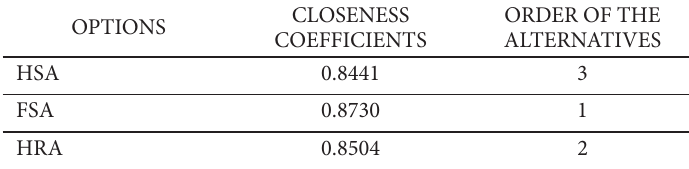
Table 9. Closeness coefficients and ranking order of the three alternatives